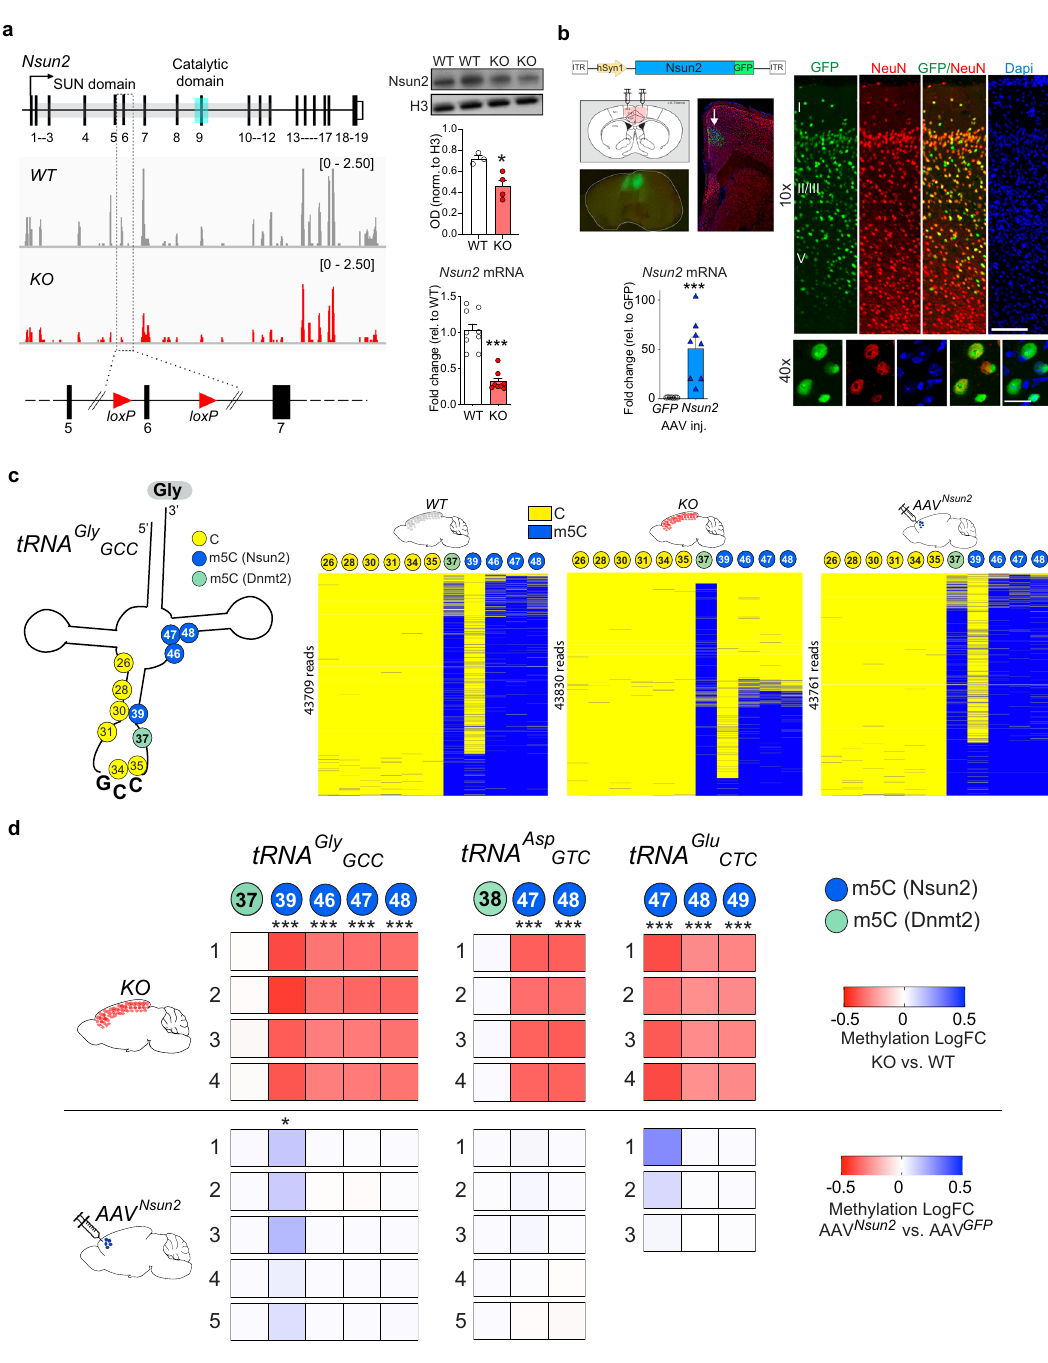
cellular stress responses 34 and observed in Nsun2-de fi cient cortex